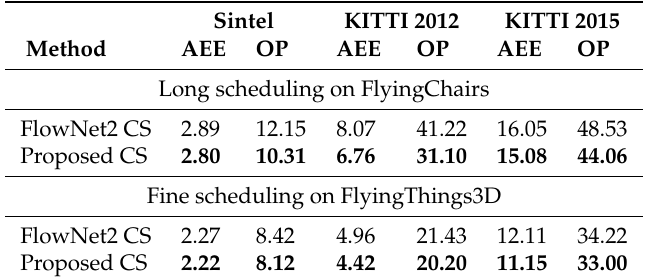
Table 2. FlowNet2 CS results vs. baseline on different training